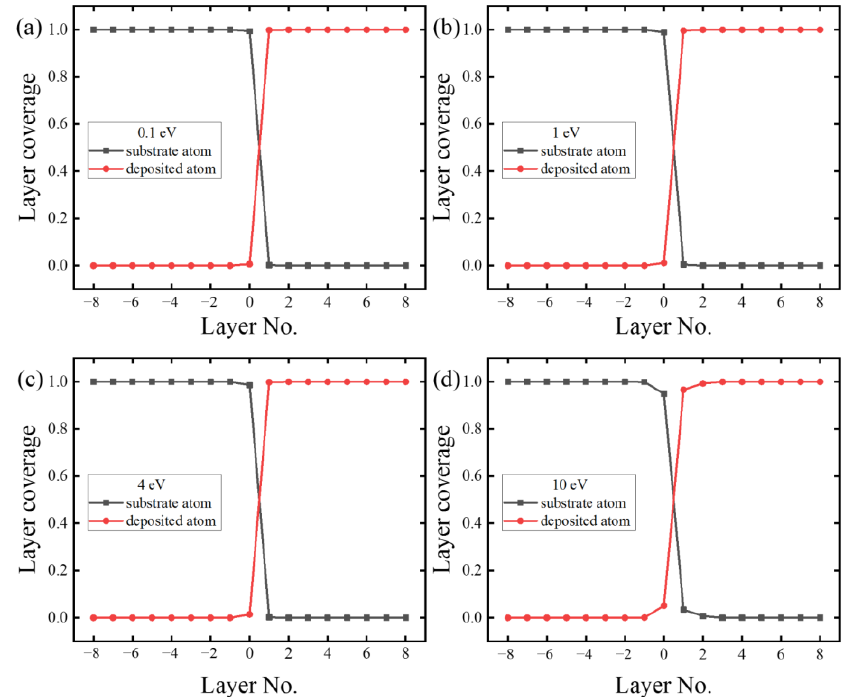
Figure 4. Layer coverage ratio of the TiN film at different incident energies. ( a ) 0.1 eV; ( b ) 1 eV; ( c ) 4 eV; ( d ) 10 eV.